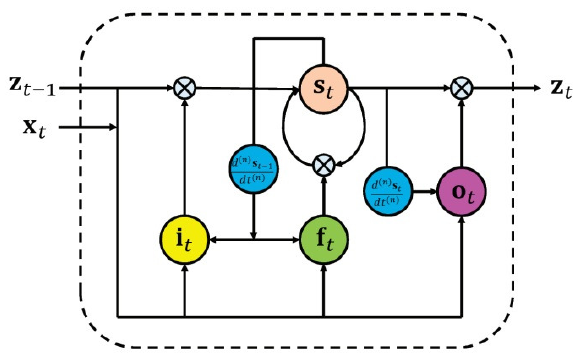
Figure 18. Architecture of the proposed dRNNmodel. In the memory cell, the input gate i t and the p n q s t ´ 1 forget gate f t are controlled by the derivative of states (DoS) d at t ´ 1, and the output gate o t dt p n q is controlled by the DoS d p n q s t at t [141]. ©2015 IEEE. Reprinted, with permission, from V. Veeriah, dt p n q